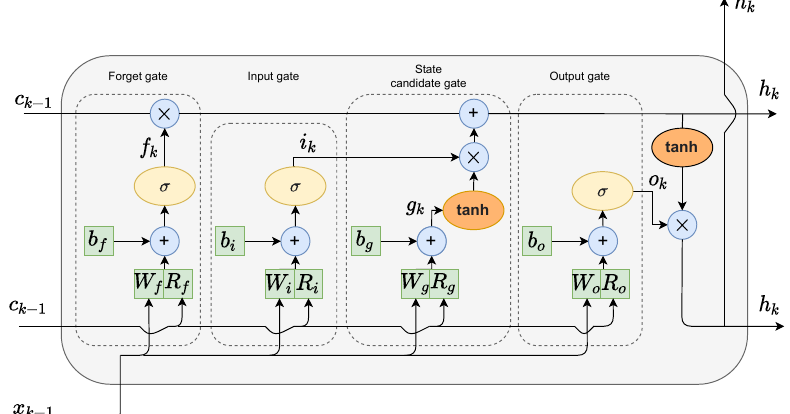
Figure 1. The LSTM cell